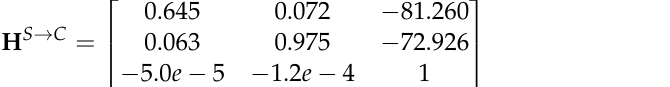
Figure 2. Illustrations of CCD-based detection of coordinates and shapes of real objects on projection plane. ( a ) The captured CCD image before calibration, where four points are given for estimating the homography matrix; ( b ) the image after calibration; ( c ) the DLP display of the coordinate of a cover; and ( d ) identifying two magnets.